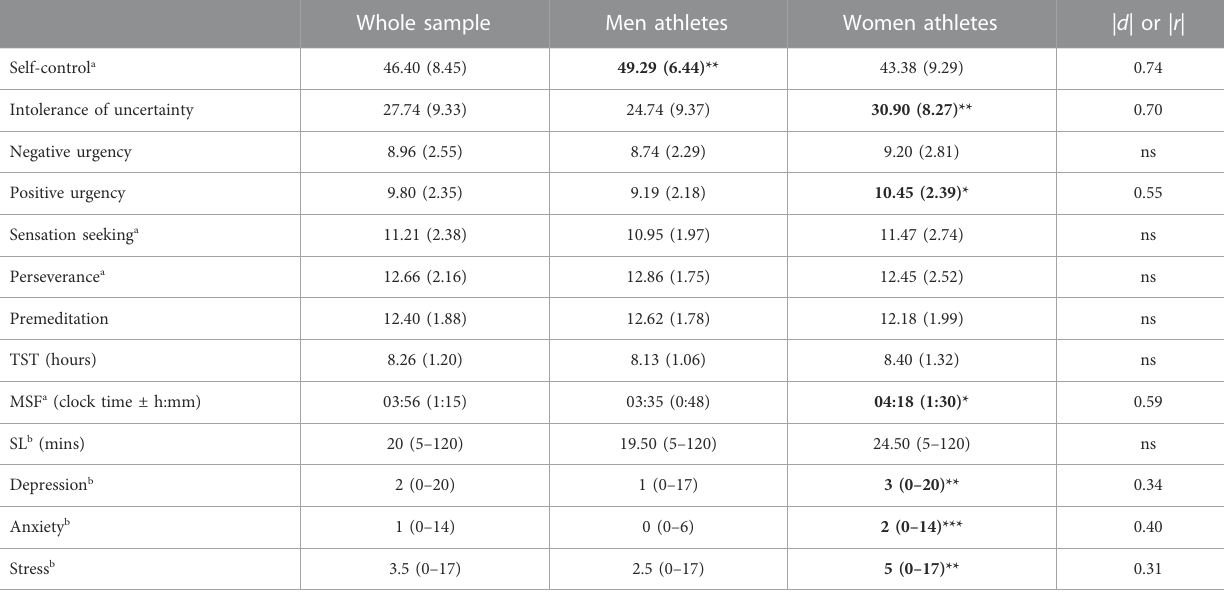
TABLE 3 Descriptive statistics for cognitive fi tness, sleep, and mental health, and pairwise gender